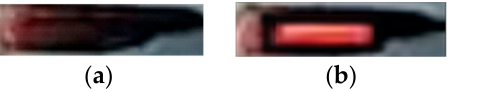
Figure 17. Vehicle taillight area image. ( a ) Unlit left taillight image; ( b ) Illuminated left taillight image.